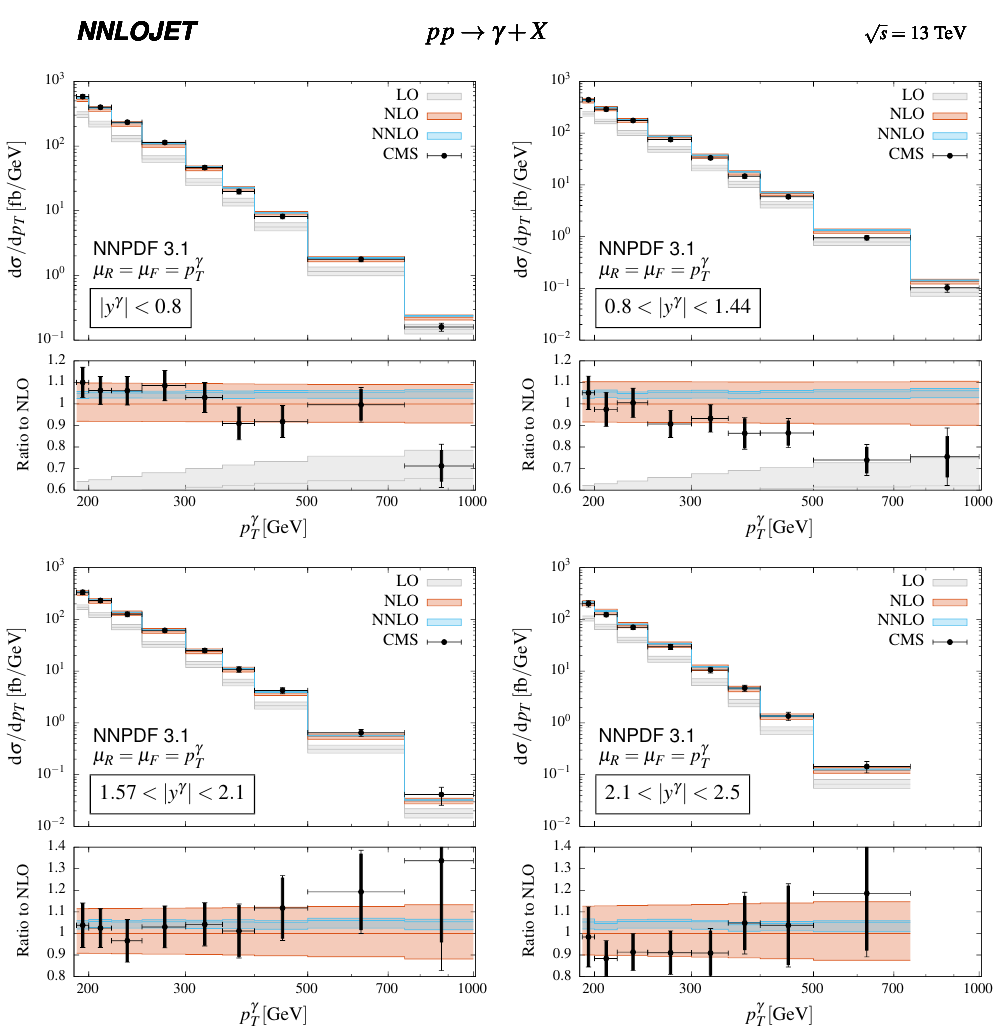
Figure 7 . Transverse energy/momentum distribution of the photon at LO, NLO and NNLO in four di(cid:11)erent rapidity bins, from central (top left) to most forward (bottom right). The results are compared to 13 TeV CMS data [12]. Note that for the sake of comparison the data has been multiplied by the corresponding rapidity bin-width, as CMS presents the data in double-di(cid:11)erential form in ( p (cid:13) ; y (cid:13) T